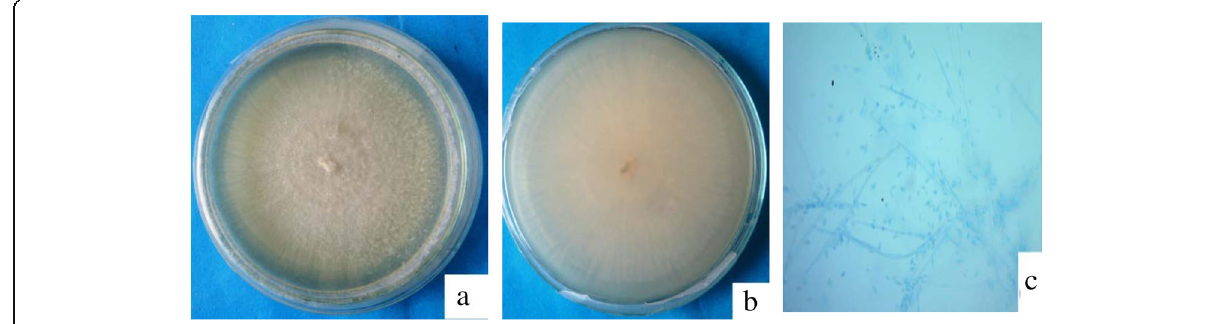
Table 1 Molecular identification using ITS regions of endophytic fungi isolated from Ceriops decandra plant Fungal Species Max Total Fusarium oxysporum 1055 1055 100 % 0 Clonostachys sp.